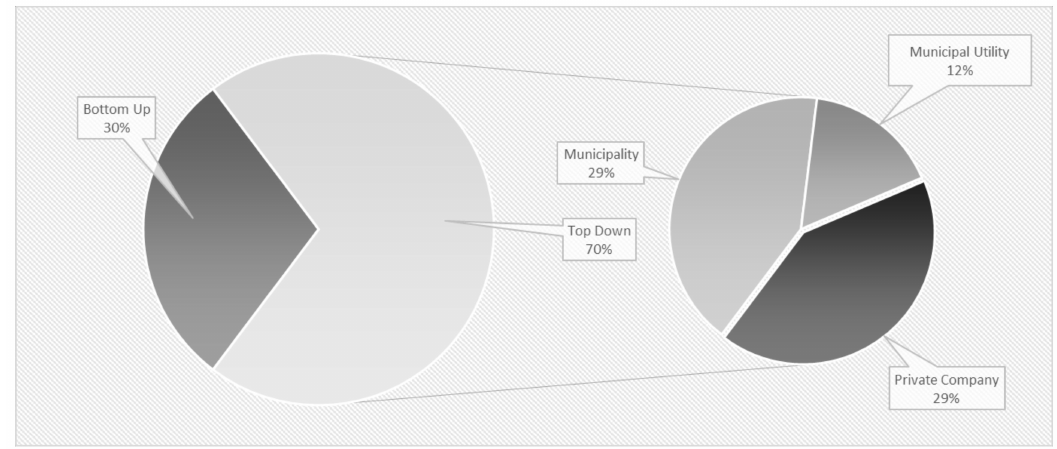
Figure 2. Dynamics of creation: top down versus bottom up approach and